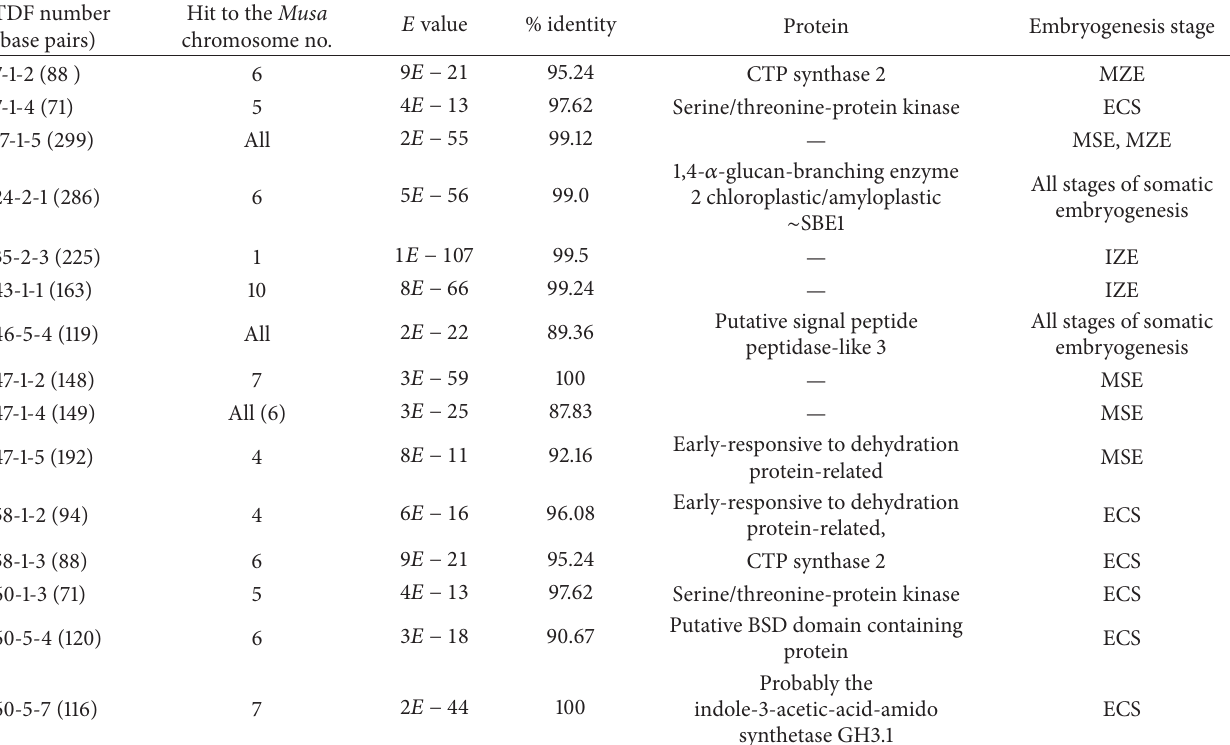
Table 2: Annotation of differentially expressed genes during different stages of somatic versus zygotic embryogenesis in Musa acuminata ssp. malaccensis and their location in the chromosomes of banana